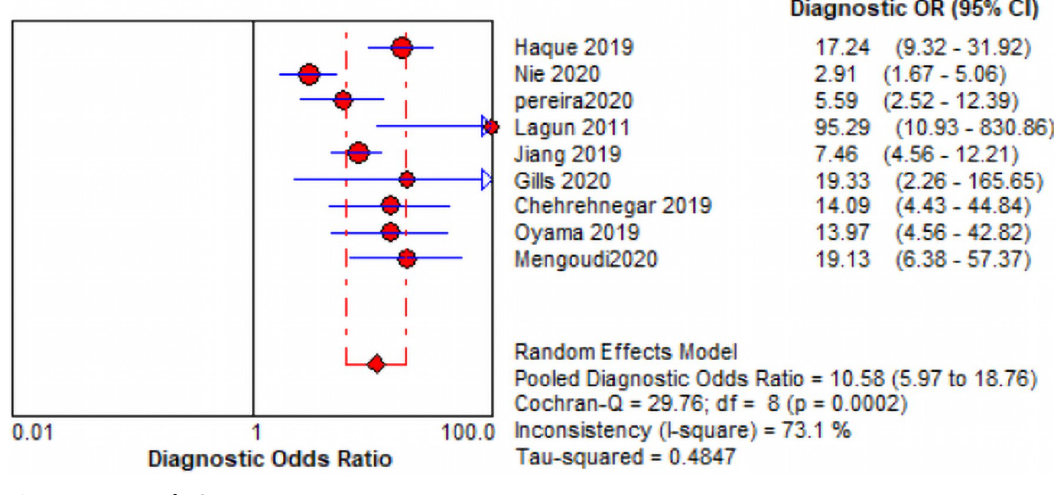
Fig 8. Forest map of DOR.